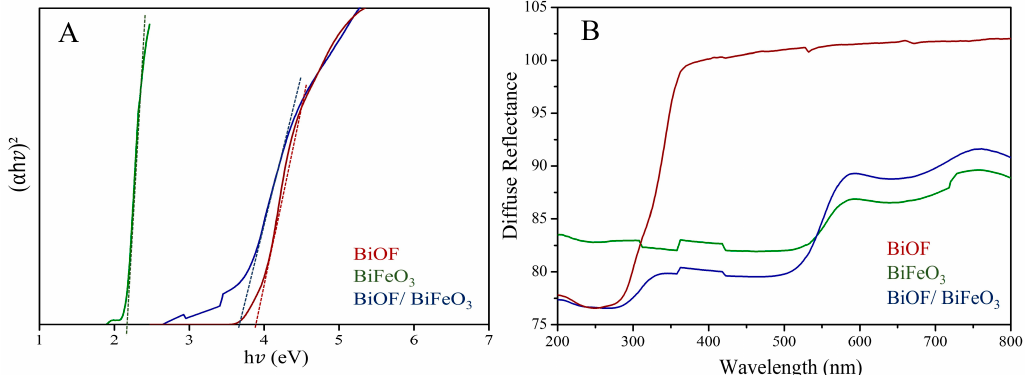
Figure 2. UV–Vis DRS spectra ( A ) and Tauc plots of prepared photocatalysts ( B ). The intercept at the x axis of the extended linear dashed lines in the graph determines the band gap values.